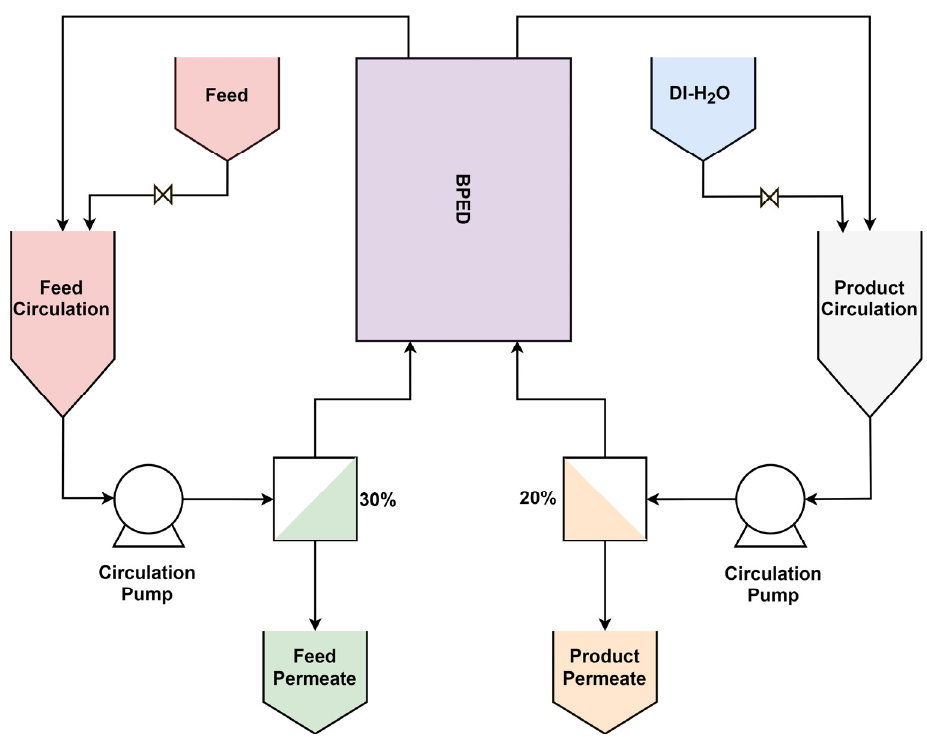
Figure 3. Schematic representation of the batch feed and bleed operation of the BPED process.